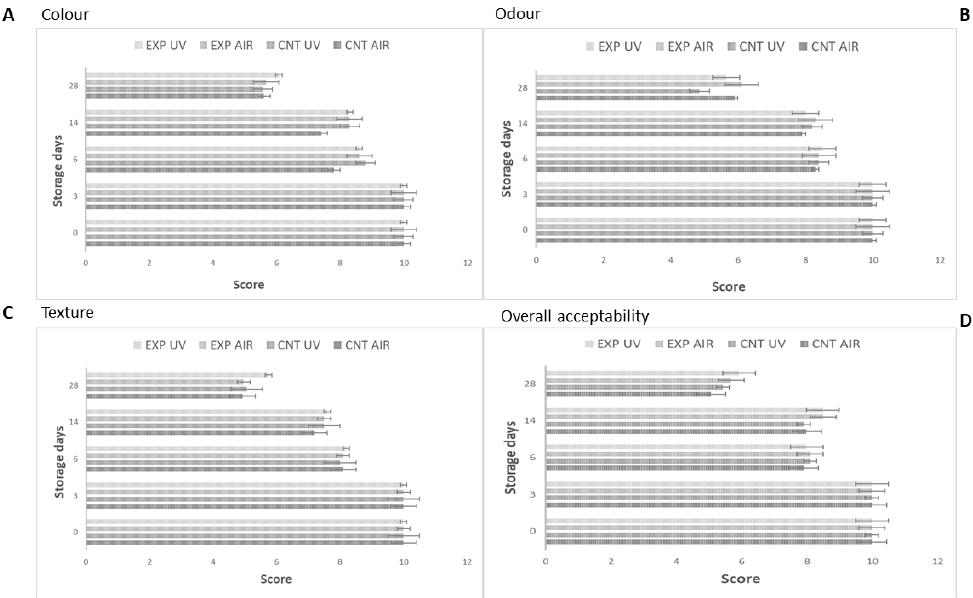
Figure 2. Sensorial scores for colour ( A ), odour ( B ), texture ( C ) and overall acceptability ( D ) of cheeses inoculated with L. monocytogenes stored at 4 °C. Mean values ± standard deviation. EXP, cheeses stored with probiotic biofilms; CNT, cheeses stored without probiotic biofilm.